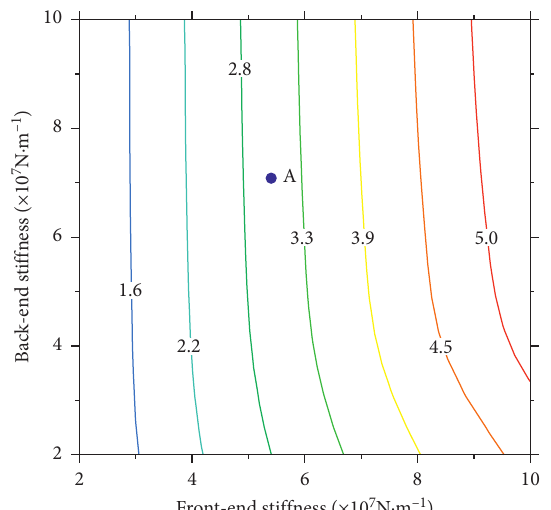
Figure 3: Change rules of spindle system stiffness with different bearing stiffness (2600 r/min).